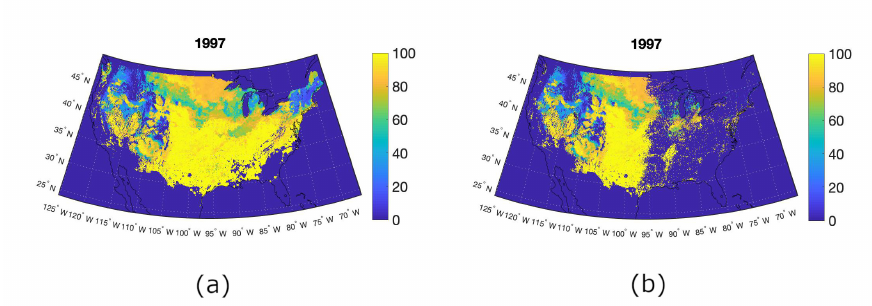
Figure 4. Percentage map of snowy days at 13.5 GHz in 1997 with ( a ) h pen > h , slope < 5 ◦ , m v < 2%, ( b ) h pen > h , slope < 5 ◦ , m v < 2%, f bare >